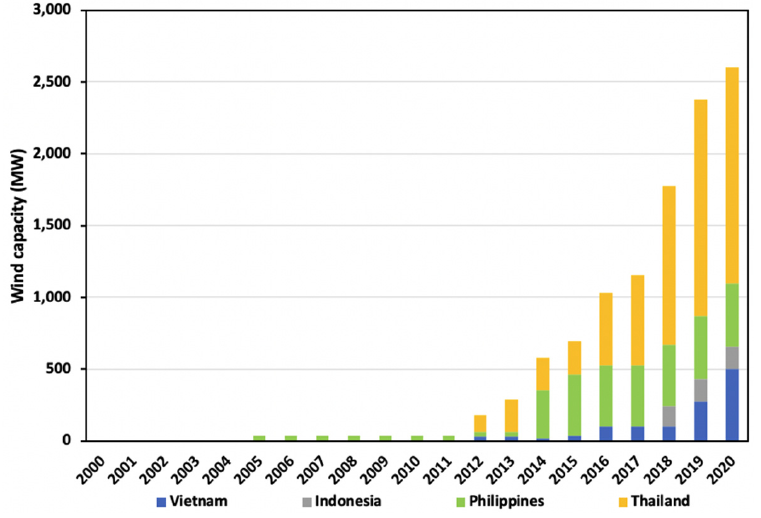
Figure 8. History of installed wind capacity in ASEAN [22] .